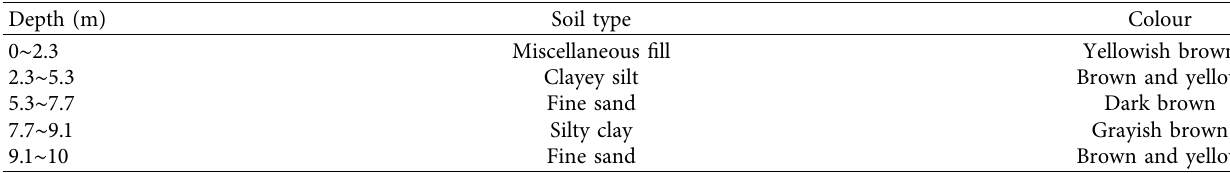
Table 3: Underground layered structure of the study